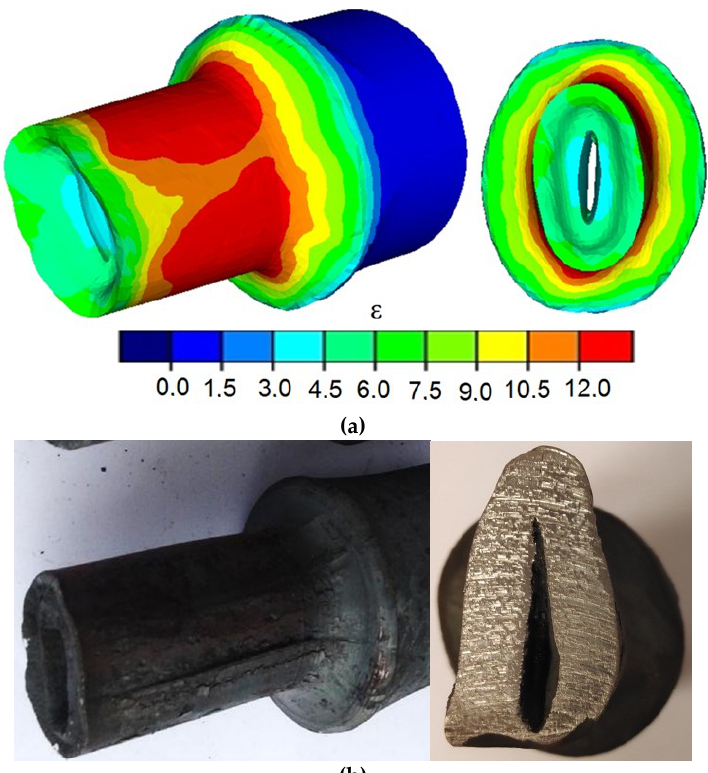
Figure 9. Deformation of the formed step as a result of wall lamination and deformation (process parameters v / n = 1 mm / rotation, t o / D = 0.16, δ = 1.5): ( a ) finite elements method (FEM)-determined shape and effective strain distribution; ( b ) shape deformation during laboratory testing